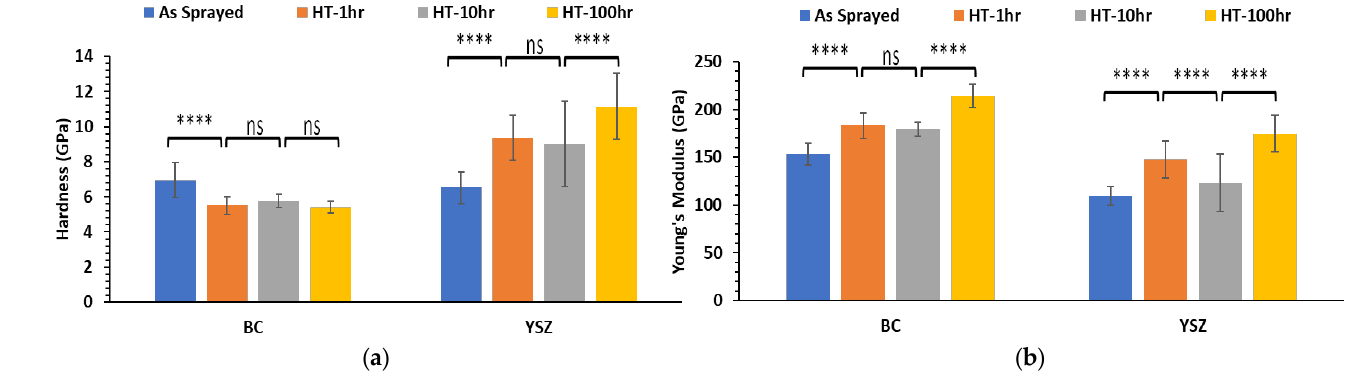
Figure 17. Nanoindentation data of the single layer TBC before and after thermal treatment ( a ) hardness (H), ( b ) elastic modulus (E). Asterisks indicate a statistical difference (* p < 0.05, ** p < 0.01, *** p < 0.001, **** p < 0.0001, obtained using Tukey test, which computes a confidence interval for the difference between two means).